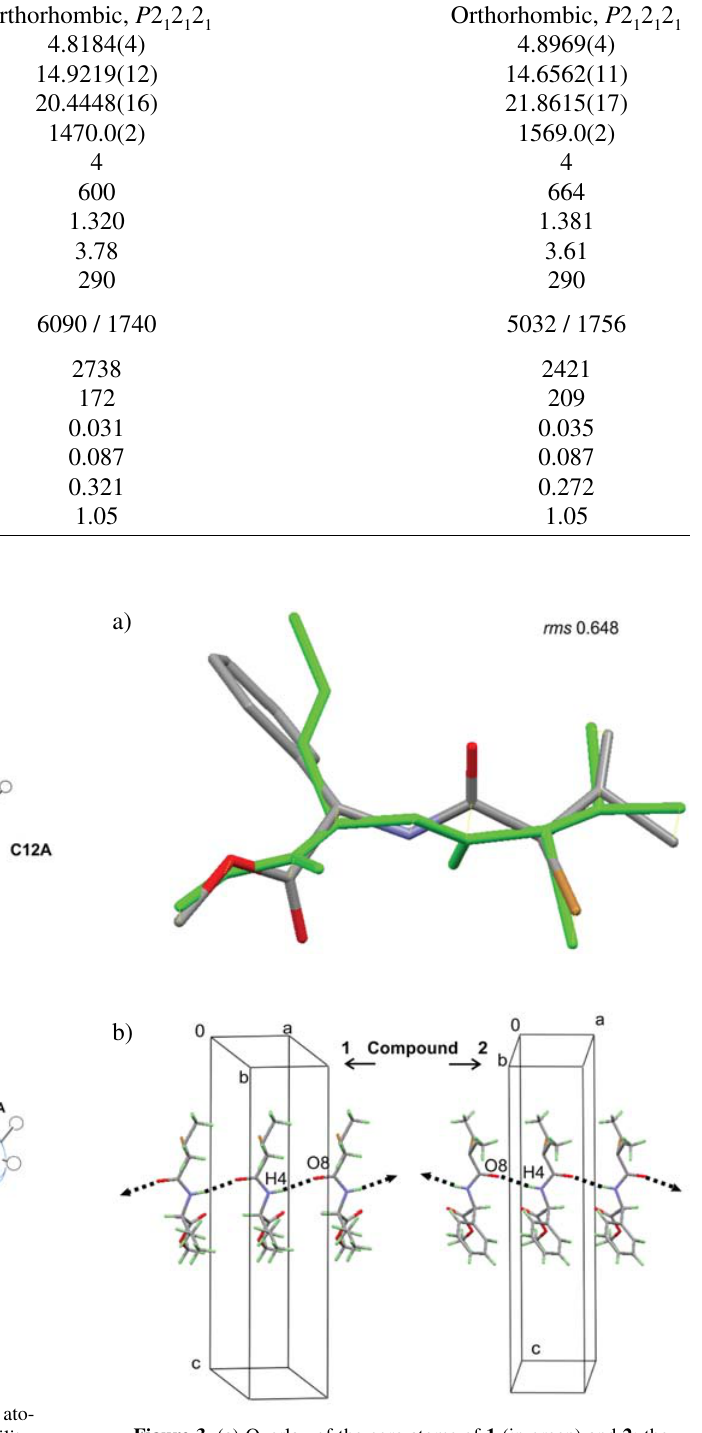
Figure 3. (a) Overlay of the core atoms of 1 (in green) and 2 ; the phenyl and propyl moieties (R 1 substituent, Scheme 1) are not used in the overlay. The rms deviation between the atomic coordinate is 0.648 Å and (b) Hydrogen bonding interaction in 1 and 2 .